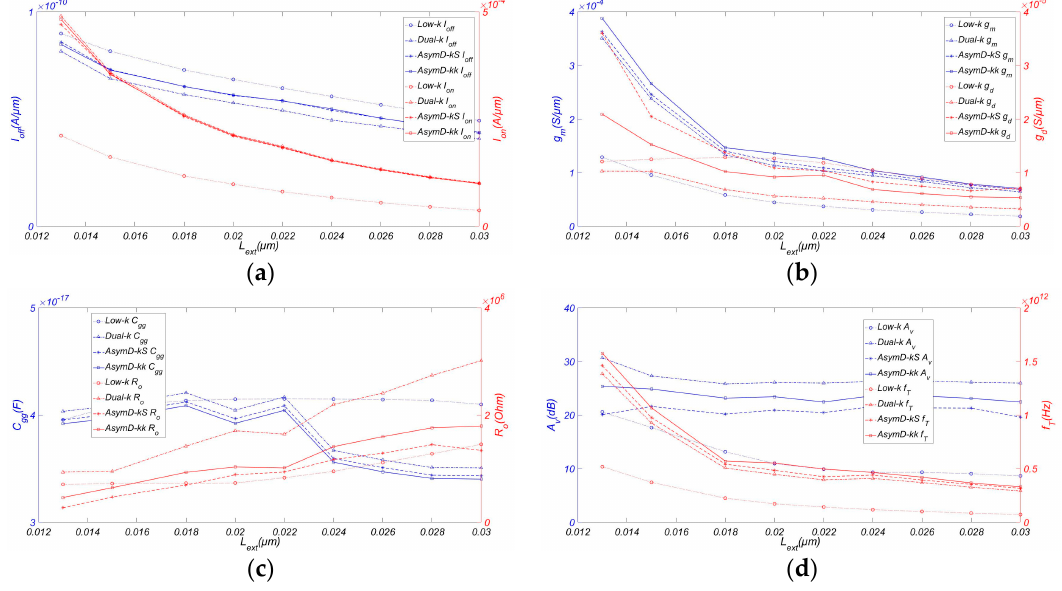
Figure 5. Variation of ( a ) I off and I on ( b ) g m and g ds , ( c ) C gg and R o , ( d ) A v and f T of FinFET with L ext Simulated with H fin = 15 nm, W fin = 6 nm, T ox = 0.8 nm, L hk = 12 nm, σ L = 3 nm, and V ds = 0.9 V.